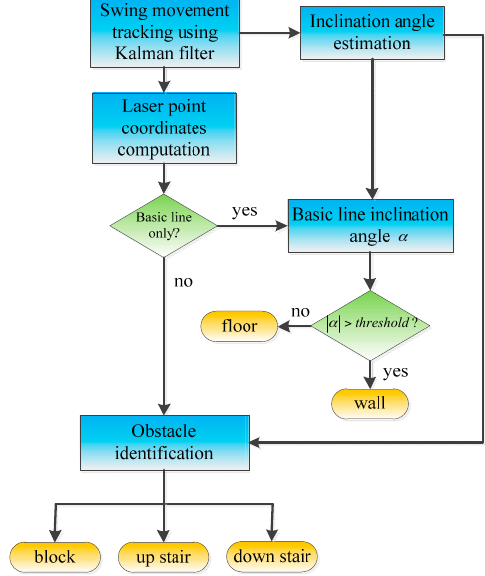
Figure 5. Obstacle classification process.